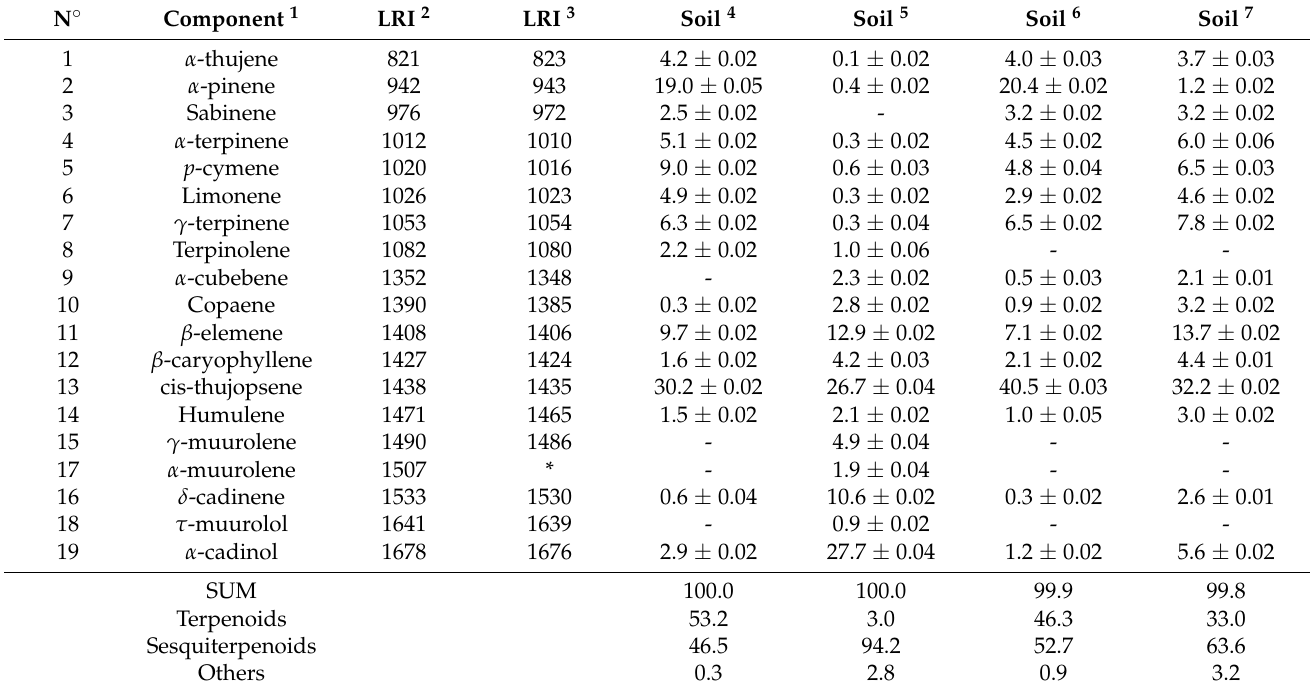
Table 2. Chemical composition (percentage mean values ± standard deviation) of soil samples with L. multiflorum and S. alba seeds in non-direct contact with J. communis